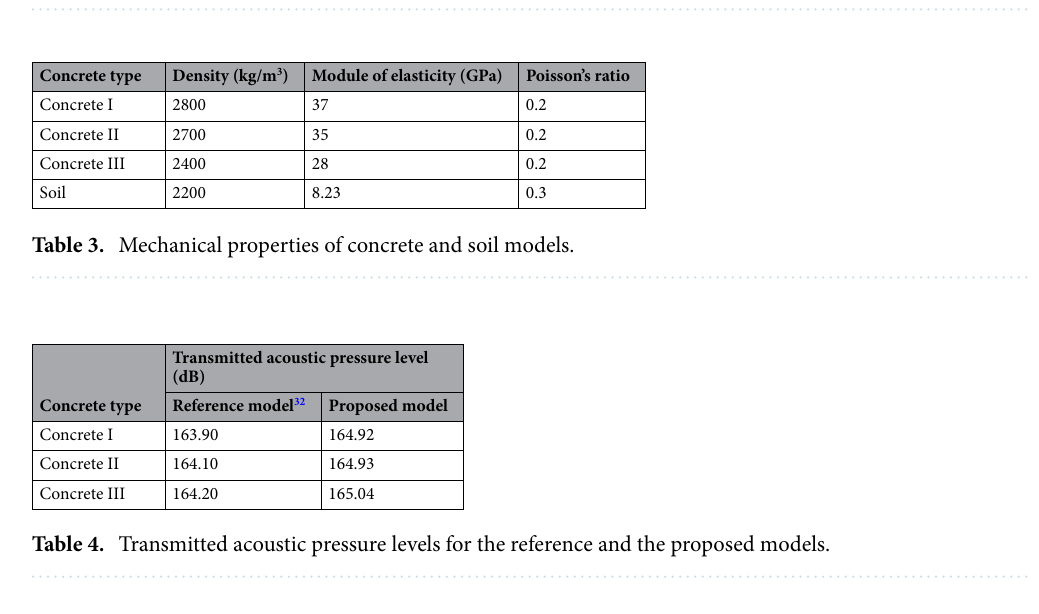
Table 2. Mechanical properties of soil layers. a Each layer’s first, second, and third rows represent their reference, stiffer, and softer soil properties.